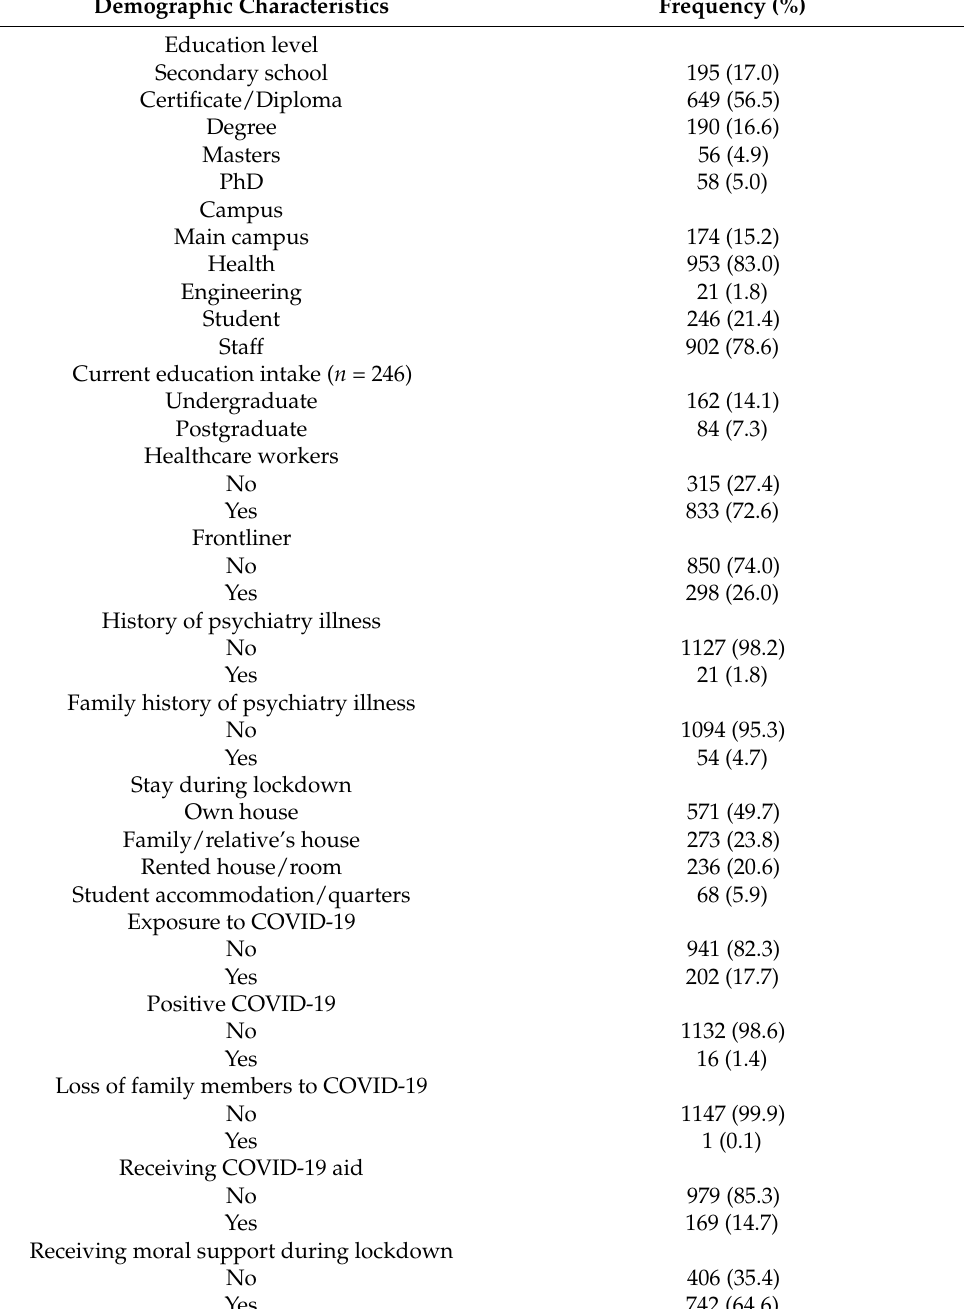
Table 1. Cont. Demographic